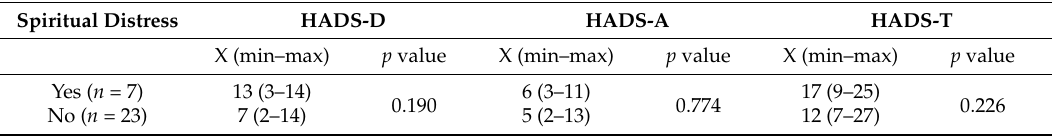
Table 6. HADS scores related to spiritual distress diagnosis.